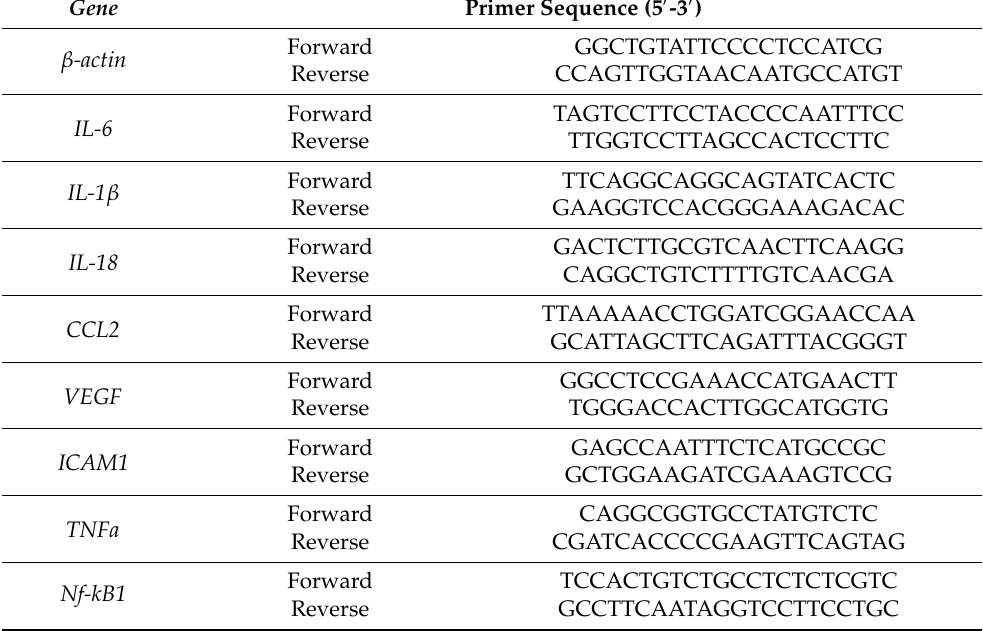
Table 1. Primer sequences of genes analyzed.